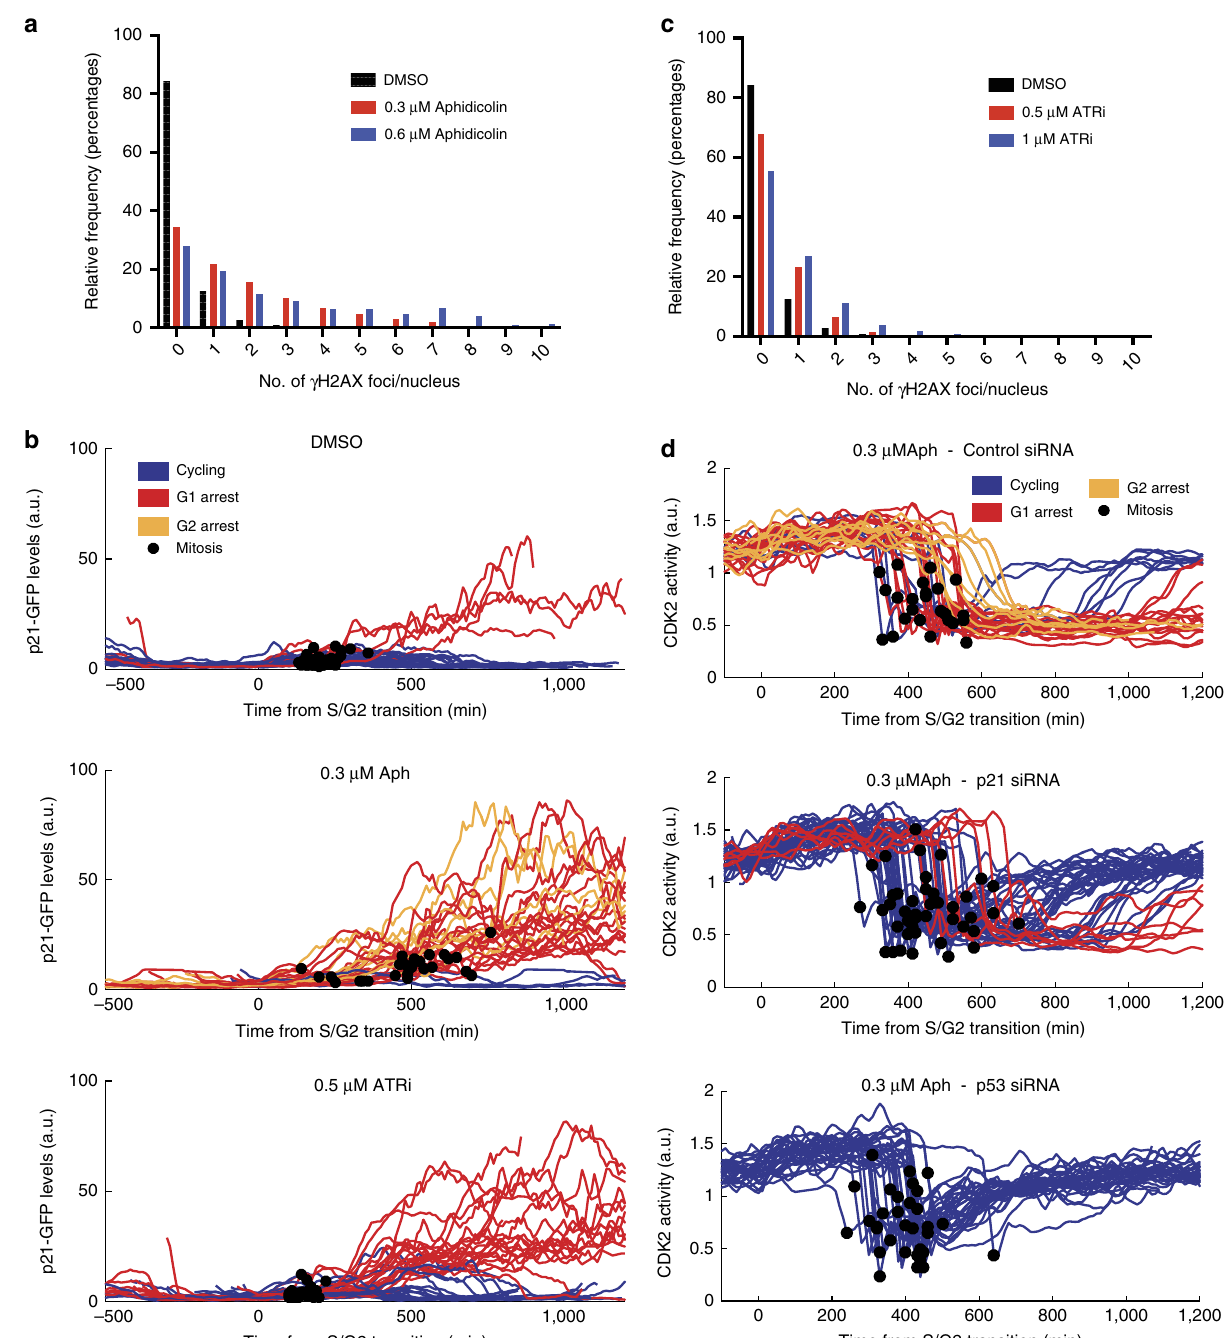
Figure 4 | Impaired DNA replication can induce p21 expression. ( a ) Number of g H2AX foci per nucleus in cells treated with DMSO or aphidicolin for 24h. DMSO, n ¼ 1527 cells; 0.3 m M Aph, n ¼ 775; 0.6 m M Aph, n ¼ 745. ( b ) Single-cell traces of p21-GFP expression after treatment of asynchronous cells with: DMSO, n ¼ 38; 0.3 m M aphidicolin, n ¼ 32; or 0.5 m M ATRi, n ¼ 40. All traces are aligned to S-phase exit. Black circles represent mitosis. Blue curves represent cells that enter S-phase, red curves represent cells that arrest in G1 and yellow curves represent cells that arrest in G2. ( c ) Number of g H2AX foci per nucleus in cells treated with DMSO or ATRi for 24h. n ¼ 1527, DMSO; n ¼ 1420, 0.5 m M ATRi; n ¼ 1467, 1 m M ATRi. ( d ) CDK2 activity profiles in cells treated with 0.3 m M aphidicolin and: n ¼ 34, DMSO; n ¼ 32, p53; and n ¼ 42, p21 siRNA, aligned to S/G2. Black circles represent mitosis. Blue curves represent cells that enter S-phase, red curves represent cells that arrest in G1 and yellow curves represent cells that arrest in G2. To further examine if DNA damage during S-phase can induce yellow curves). This suggests that when levels of damaged DNA, p21 accumulation in G2, we treated cells with an ATR kinase and corresponding p21 levels, exceed a threshold, CDK2 activity inhibitor (ATRi; AZD6738) to induce destablization of stalled is inhibited and cells undergo G2 arrest. Overall, these data show DNA replication forks 32 . Treatment with ATRi leads to an that by inducing aberrant DNA replication with aphidicolin, cells activate p21 expression, downstream of p53, which promotes increase in the proportion of cells with a single g H2AX focus, in either a G1 or G2 arrest. the number of g H2AX foci per nucleus, and in p53 expression NATURE COMMUNICATIONS|8:14728|DOI: